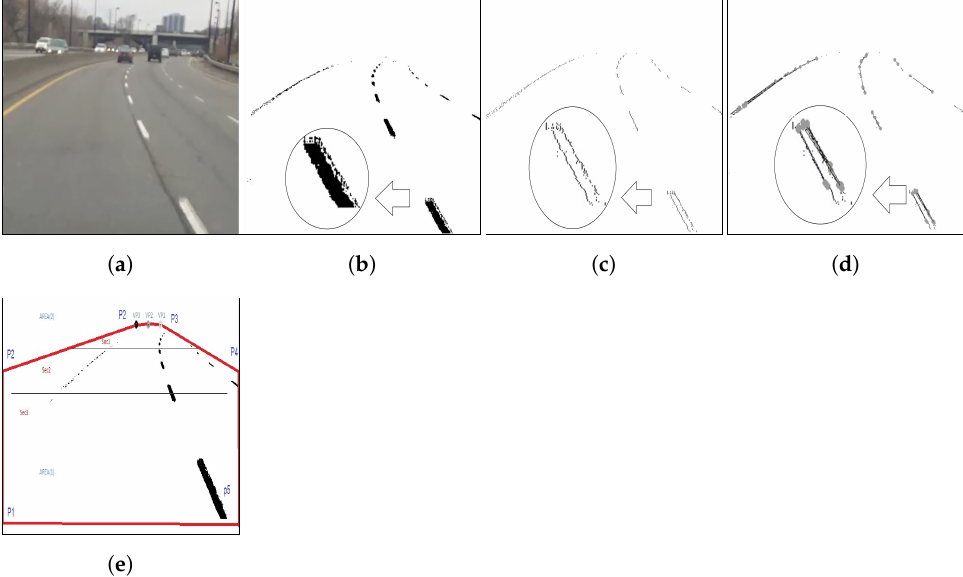
Figure 3. An example of preprocessing of image frames. ( a ) Raw image of the frame; ( b ) after selective segmentation; ( c ) after noise filtering and thinning; ( d ) after probabilistic Hough transform; ( e ) after extracting regions of